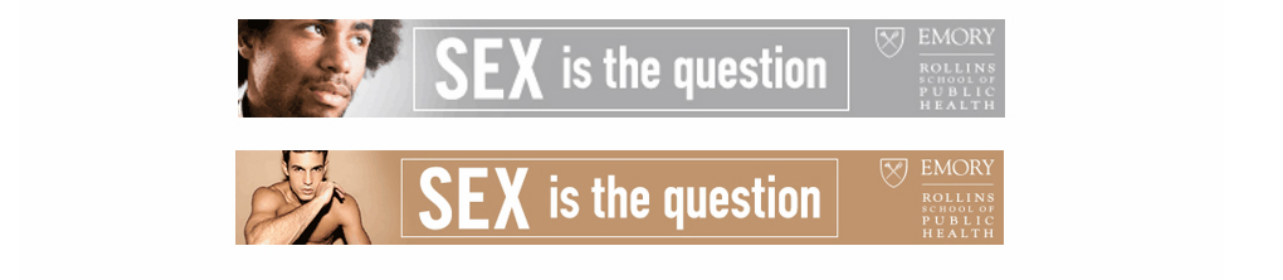
Figure 1. Example Banner Advertisements Used for the American Men’s Internet Survey,